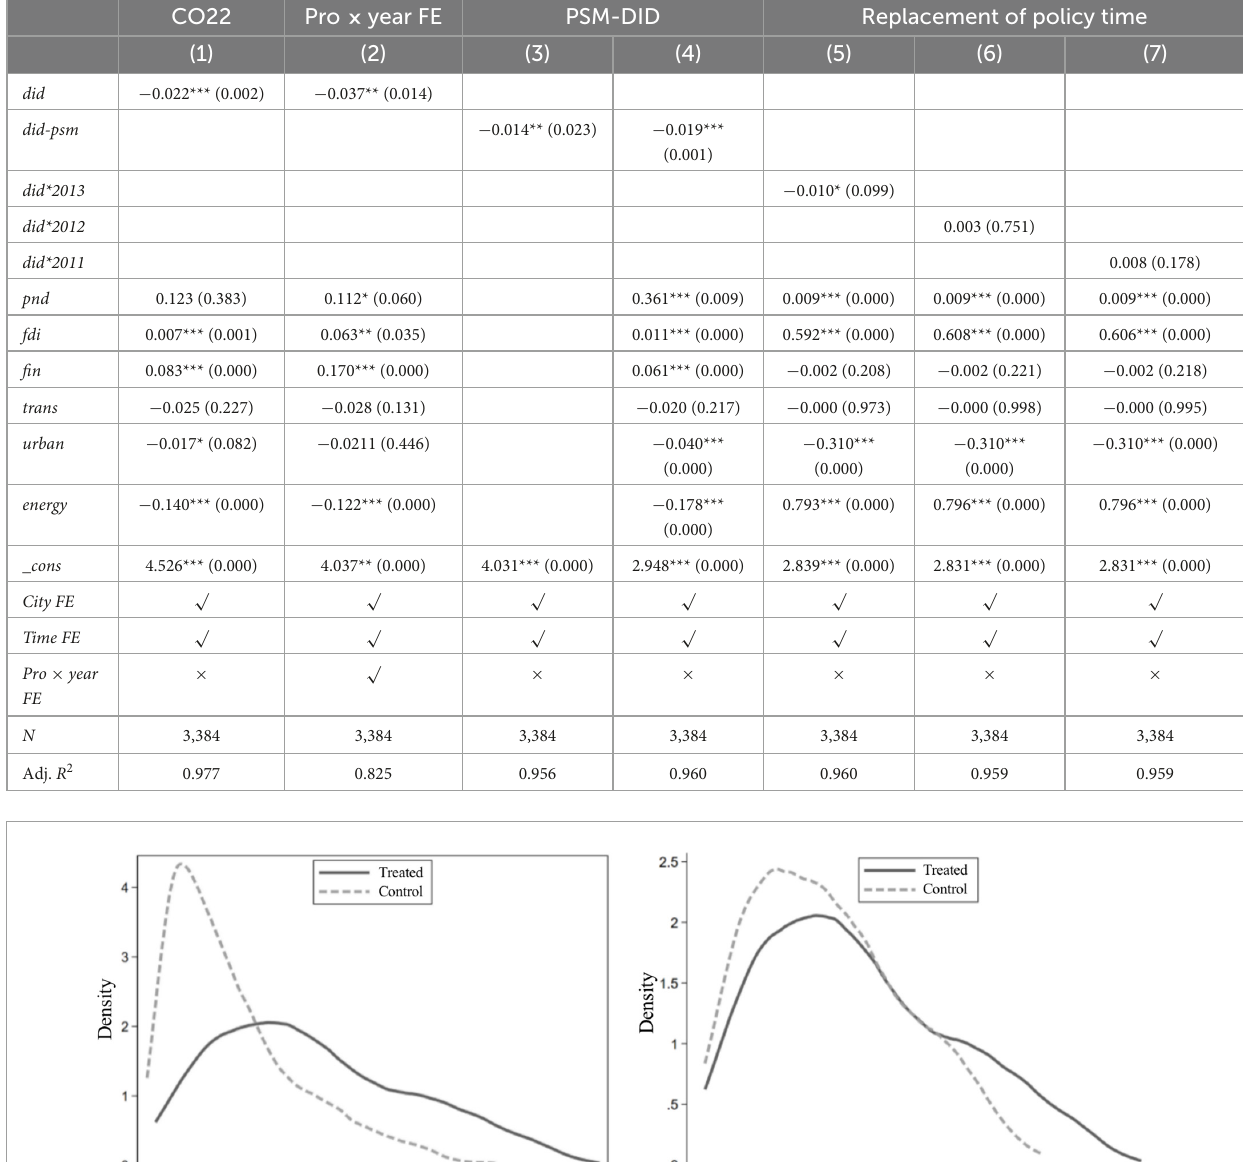
TABLE 3 Robustness results.